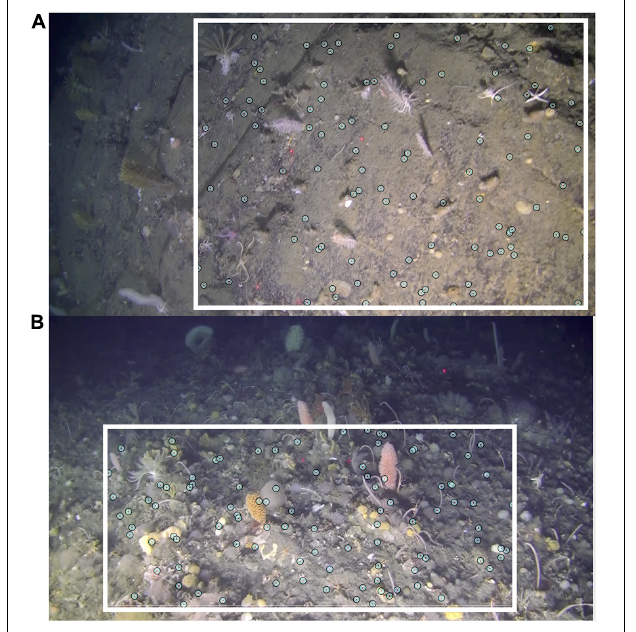
FIGURE 3 | Example of the approach taken to correct for differing camera angles during image analysis using features available in PAPARA(ZZ)I. (A) Wall off Lecointe Is (Dive 7). (B) Flat terrain off Trinity Is (Dive 5).